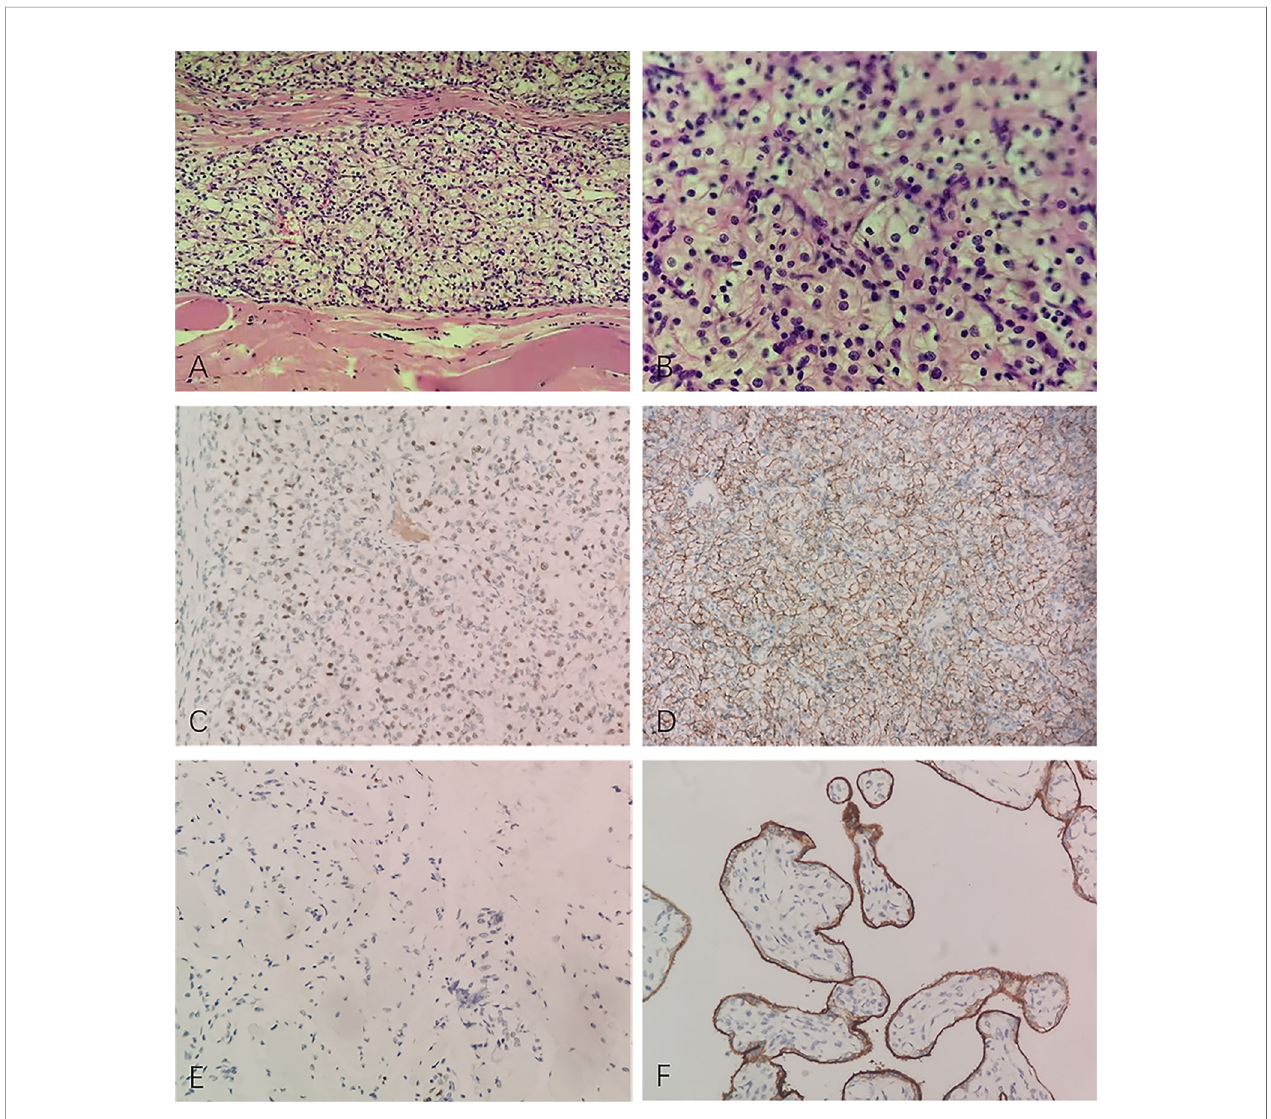
FIGURE 2 | Pathological manifestations of masseter muscle metastasis. Hematoxylin – eosin staining (×200): tumor tissue in fi ltrates in striated muscle tissue, with rich blood sinuses (A) . Hematoxylin – eosin staining (×400): tumor cells share the morphology of clear cytoplasm (B) . Immunohistochemistry: Pax-8 (C) , CA IX (D) , Ki-67 (5%) (E) and PD-L1 (22c3, CPS ≈ 1) (F) are positive. The fi gure was obtained in